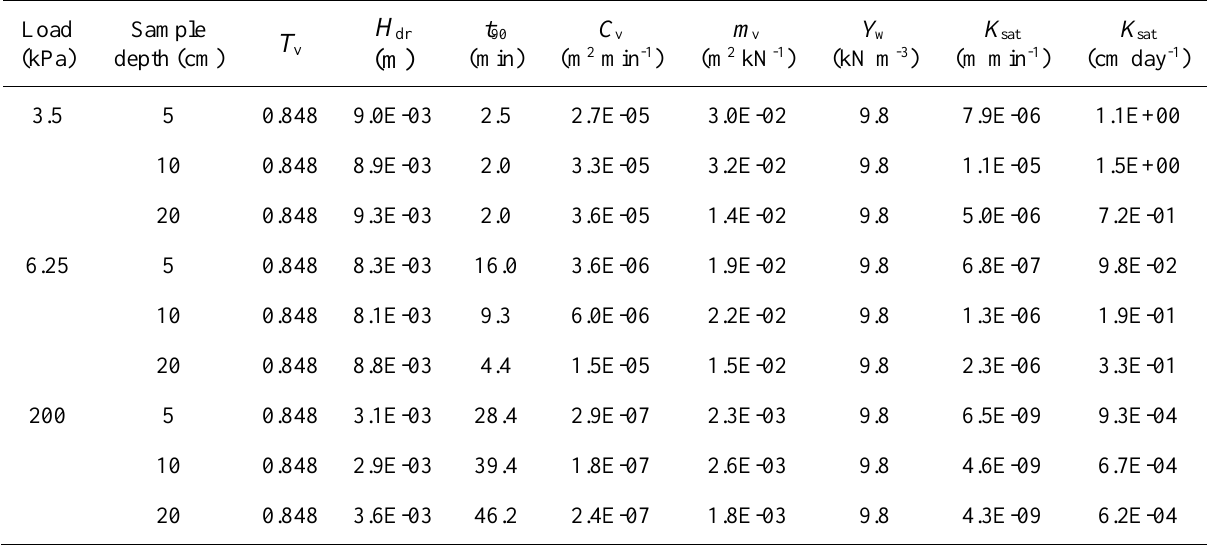
Table 3. Hydraulic conductivity from compressibility tests. Note: 1 kPa is equal to 1 kN m -2